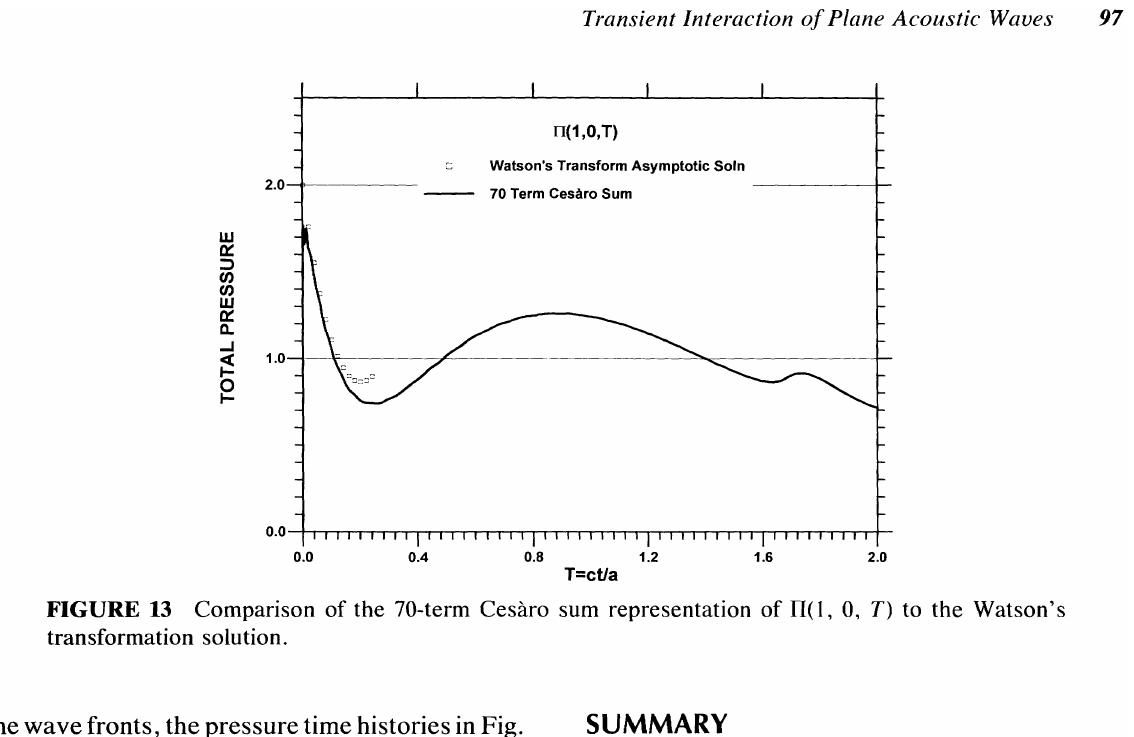
FIGURE 13 Comparison of the 70-term Cesaro sum representation of ITO, 0, T) to the Watson's transformation solution.